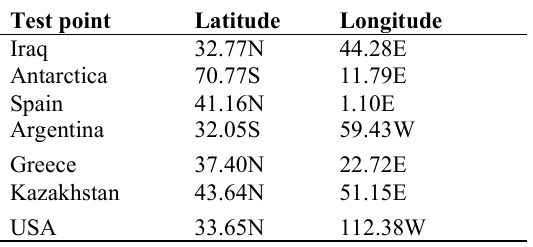
Shows HF circuit points geographical locations. Test point